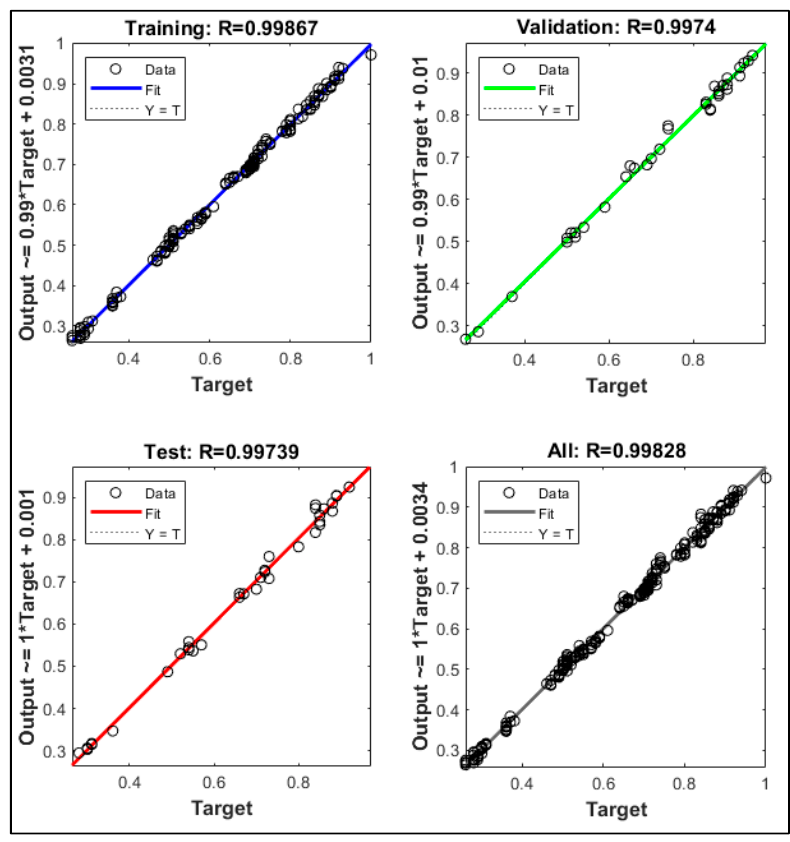
Figure 7. Regression plot extracted from MathWorks MATLAB R2021b.